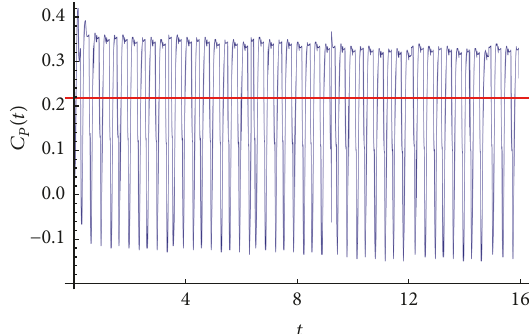
Figure 10: Time evolution of the power coefficient 𝐶 𝑃 (𝑡) at Re = 1.96 ⋅ 10 5 and 𝜔 = 0.9 . The red line corresponds to the average value 𝐶 𝑃